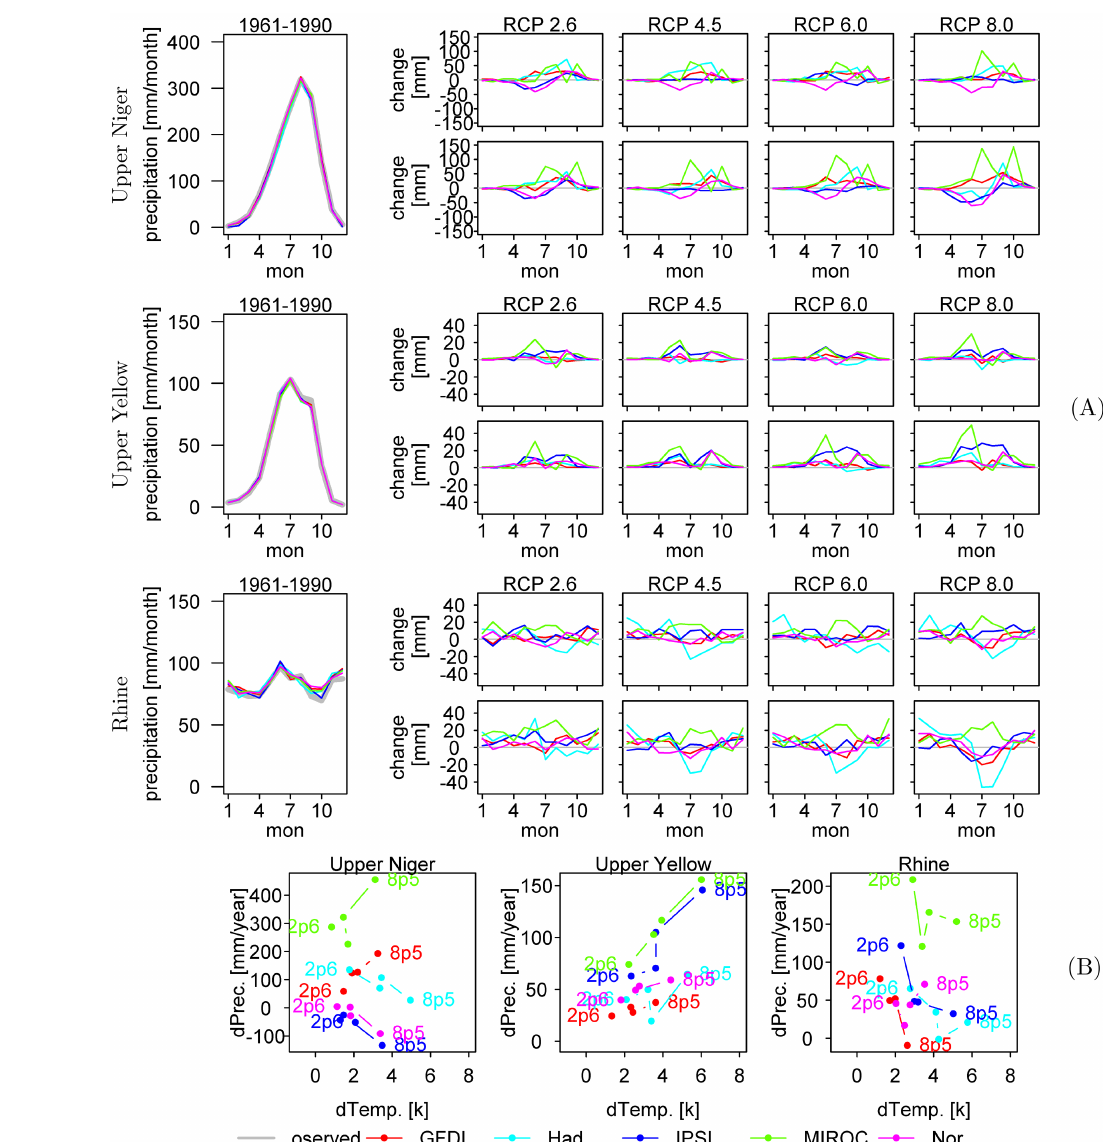
Figure 4. Evaluation of precipitation ( P ) and temperature ( T ) simulated by five climate models in three basins. (a) Left: comparison of the observed and simulated long-term average monthly P in the reference period 1961–1990; right: differences between simulated P in two scenario periods 2021–2050 and 2061–2090 and that in the reference period for four RCPs: 2.6, 4.5, 6.0, and 8.5. (b) The long-term average annual changes in P (dPrec) in relation to the long-term average annual changes in T (dTemp) in the second scenario period related to those in the reference period for four